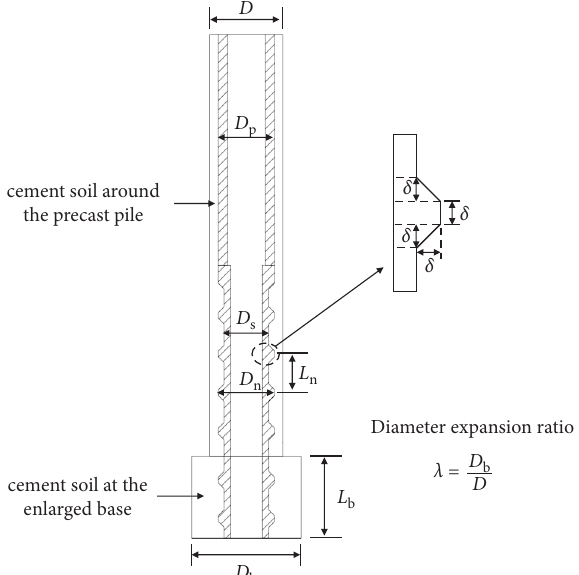
Figure 10: Schematic diagram of the pile structure of the PPEB